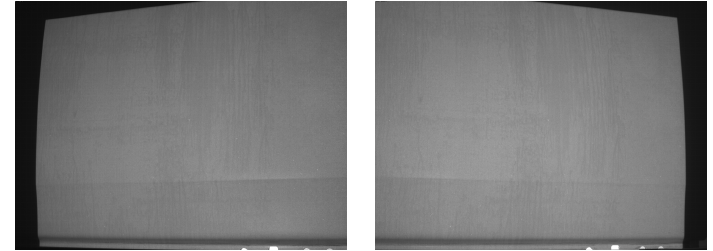
Figure 2. Left and right camera views for the measurement patch of a sheet metal car door